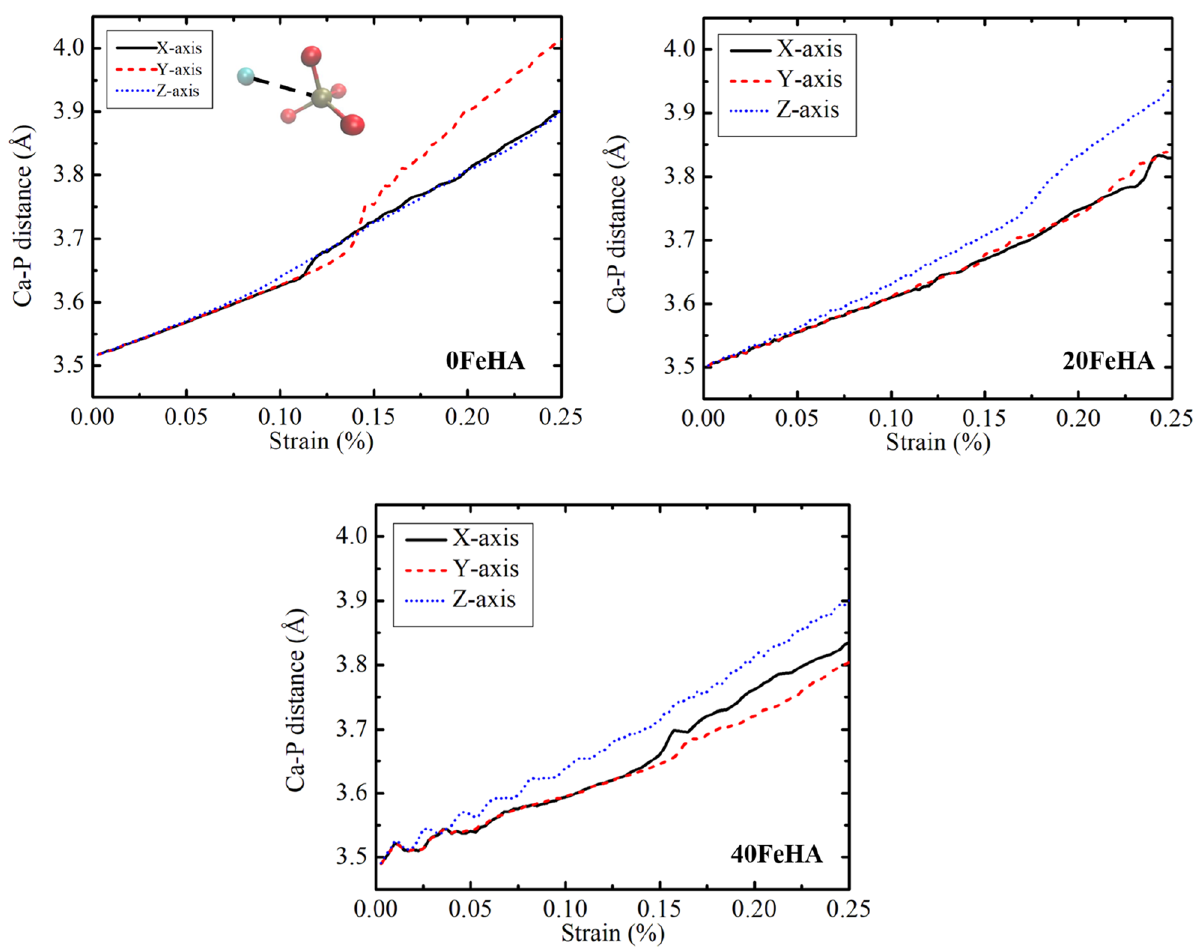
Figure 8. MD simulated dynamic changes in distance between Ca 2+ and P 5+ ions with uniaxial tensile strain, for different doped HA at T = 10 K. The distance has been defined schematically in the inset. Atomic colour code: Ca: pale blue, O: red, P: golden-yellow. (Sample designation: xFeHA means x mol% Fe 2+ -doped HA).